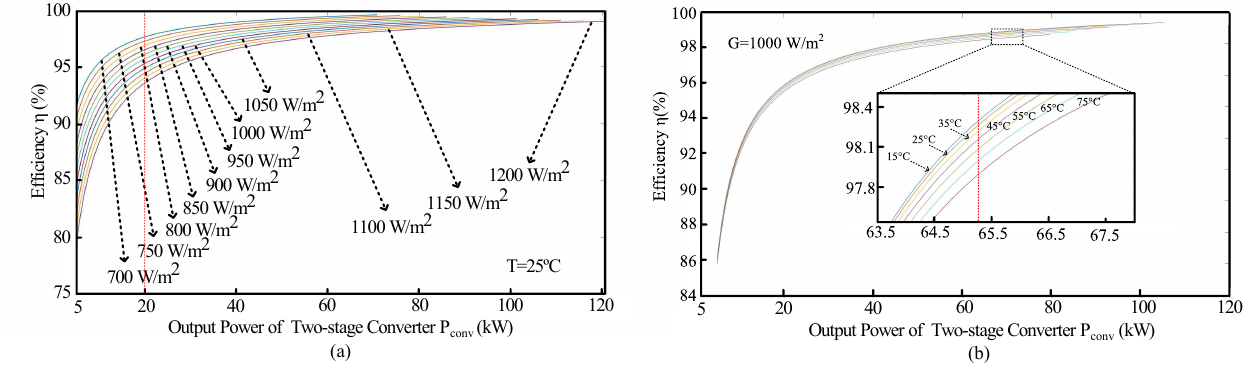
Figure 15. Efficiency curve with various weather conditions when operating on left side of MPP: ( a ) η - P conv curve with different irradiance, and ( b ) η - P conv curve with different